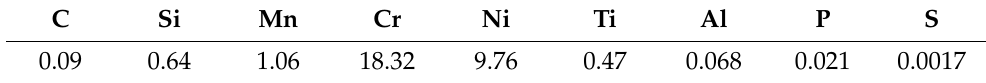
Table 1. Chemical composition of the SUS321 (Mass pct).